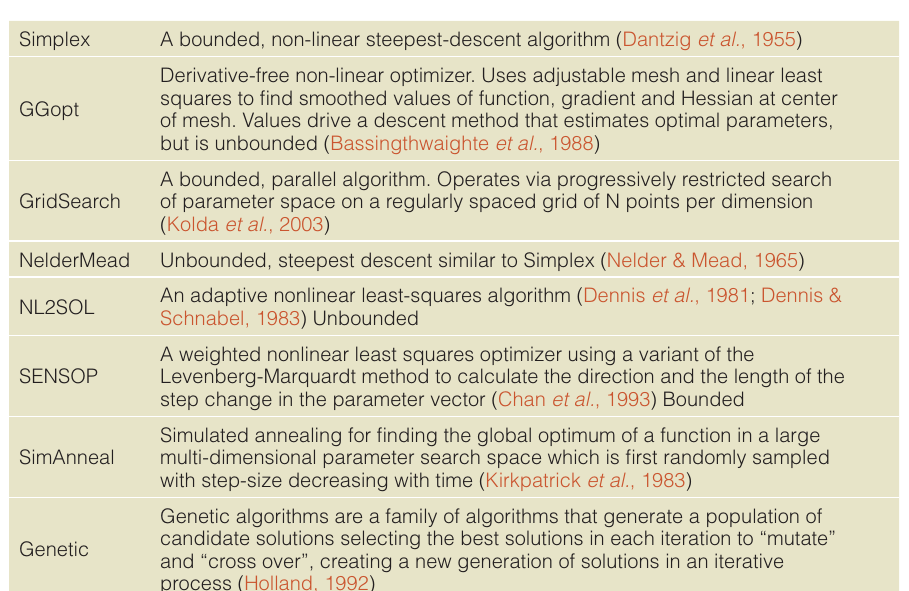
Figure 4. Sensitivity analysis using the same model as in Box 2 and Figure 2 and Figure 3. Upper panel : Model solution for outflow from capillary. Parameters were as in Box 2, the default parameters. Middle panel : Sensitivity function, df/dp , the change in C with a 1% increase out in the capillary wall conductance (PS), black curve or the interstitial volume (V ). Lower panel : Normalized sensitivity function, (df/f)/(dp/p) , isf the fractional change in C divided by the fractional change in each parameter, again for a 1% change in the parameter value. out fluid volume (V ) or capillary wall conductance (PS) following an isf injection of that solute at the capillary entrance. The upper panel shows the outflow concentration without parameter perturbation. The middle panel plots the unnormalized sensitivity functions, and the bottom plot shows the normalized sensitivity functions (with the early part of the curves removed when C is negligible). Increas- out ing PS will lower the height of C for the first 10 seconds with the out greatest reduction at the peak of C at ~8 seconds (due to greater out flux of metabolite into the ISF); after 10 seconds, the height of C out will be increased (back flux of metabolite from ISF). Increasing V isf Table 3. JSim’s